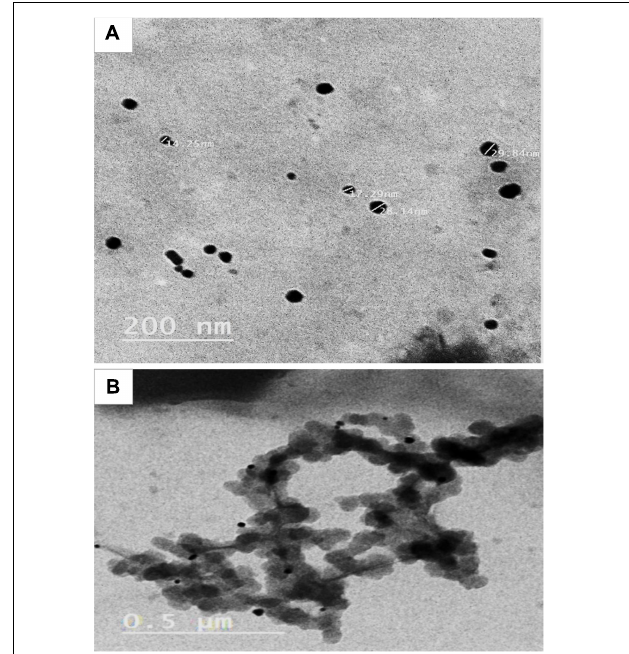
June drop percentage: In May 2019 and 2020, the